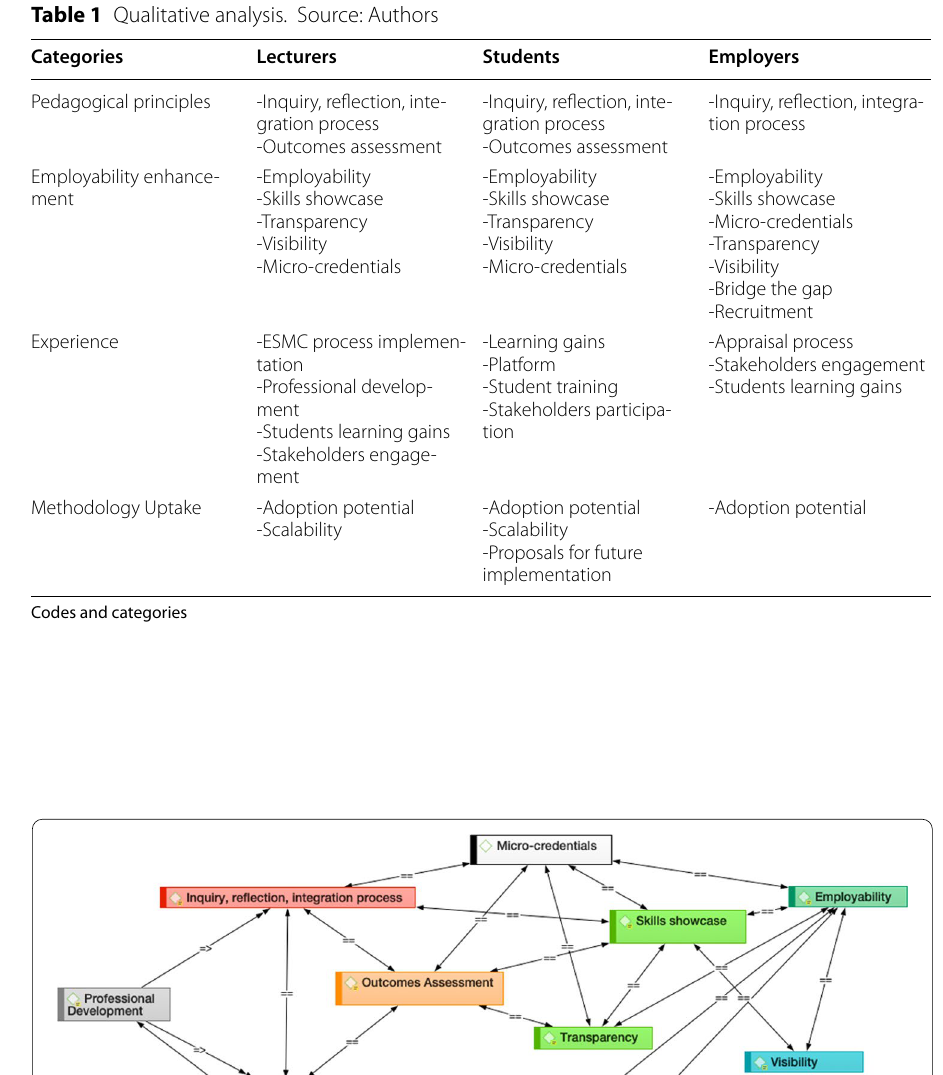
Table 1 Qualitative analysis. Source: Authors